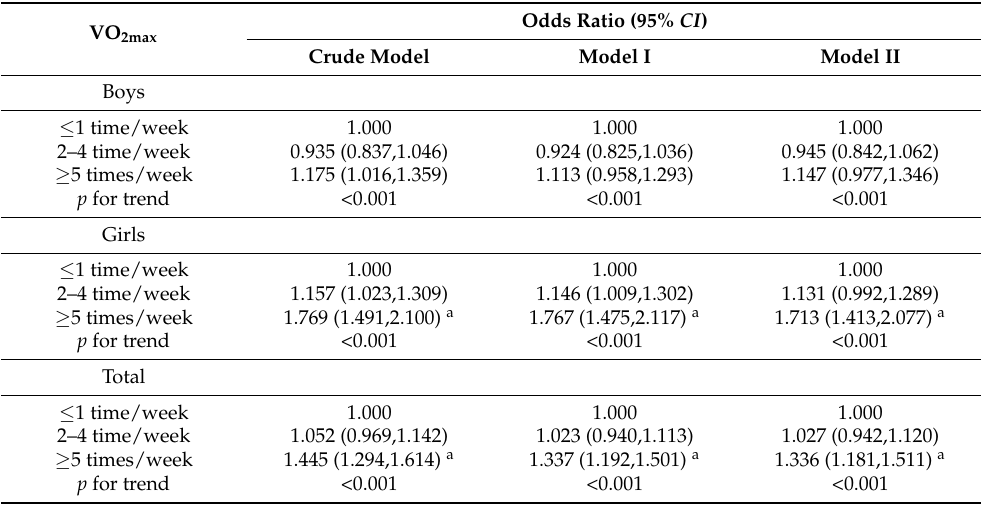
Table 5. Logistic regression analysis of VO 2max in children with different SSB consumption in China (n =